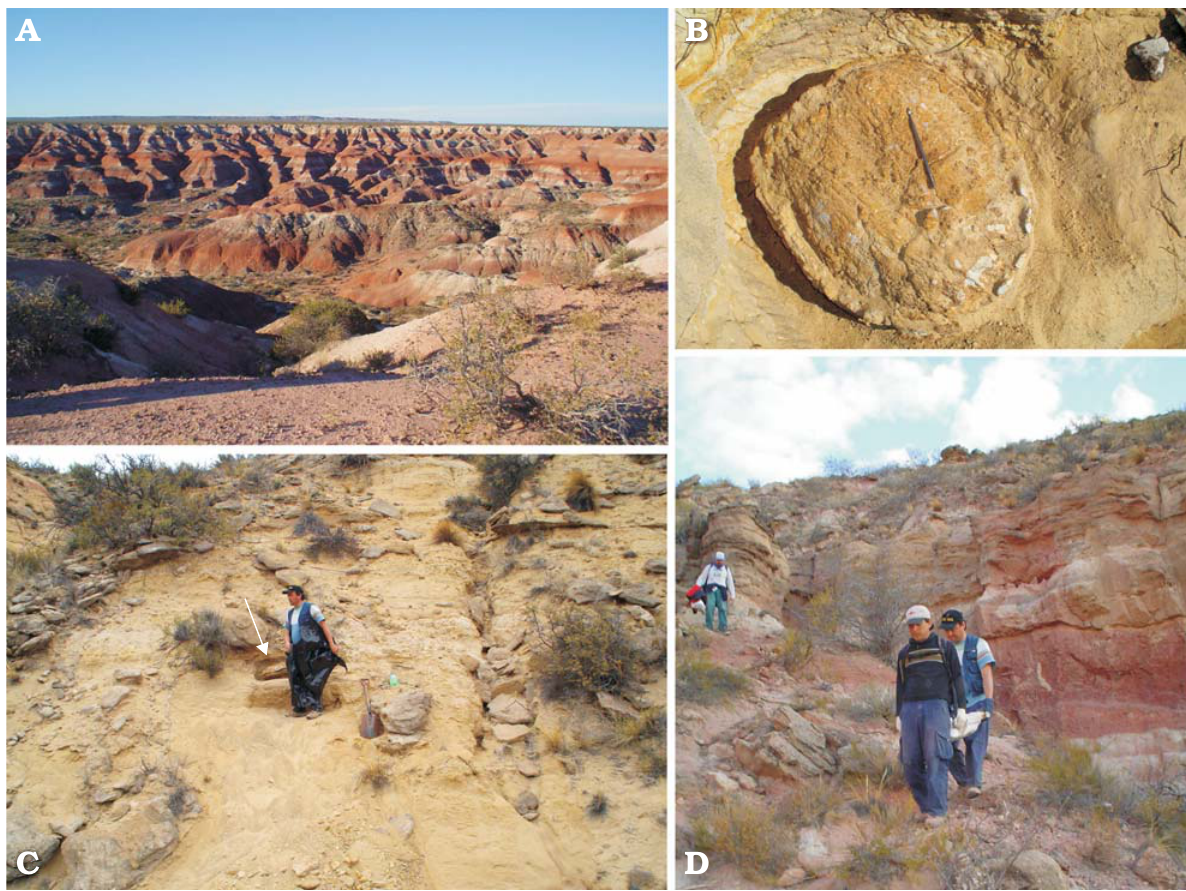
Fig. 3. A . General view of the Upper Cretaceous outcrops of the “El Anfiteatro” area, northern Patagonia, Argentina, where the holotype of Rionegrochelys caldieroi gen. et sp. nov. was found. B . In situ photograph of the holotype of Rionegrochelys caldieroi gen. et sp. nov. C . Levels of the Plottier Formation (arrow indicates the location of specimen). D . Transportation of the